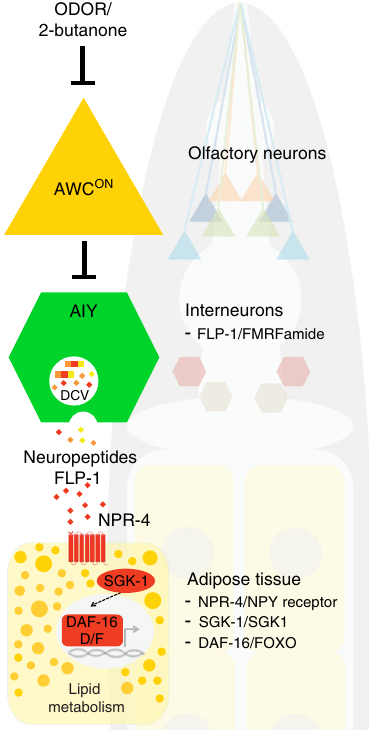
Fig. 7 Olfaction regulates lipid metabolism through neuroendocrine signaling mechanisms. Between two asymmetric AWC olfactory neurons, only AWC ON regulates peripheral lipid metabolism. In response to speci fi c environmental odors, this olfactory neuron signals through a speci fi c downstream neural circuit and neuroendocrine signaling pathway (conserved components in mammals are indicated) to directly control lipid homeostasis in peripheral metabolic tissues. DCV, dense core